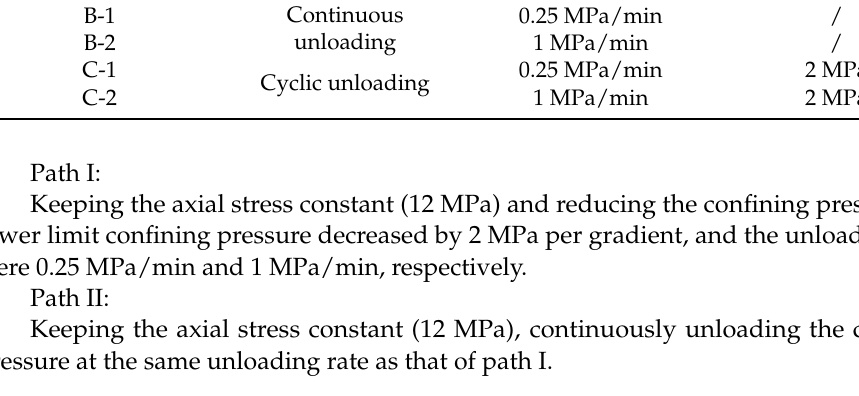
Figure 3. Unloading path.